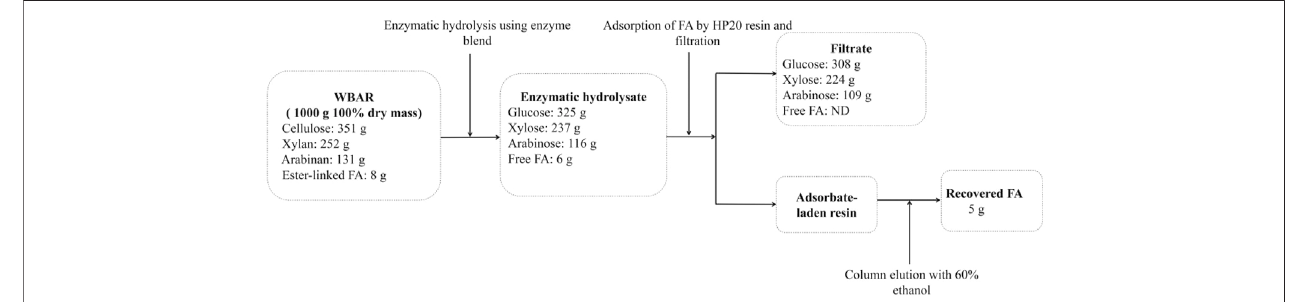
FIGURE 4 | Mass balance of the monosaccharides and ferulic acid from wheat bran autohydrolysis residue. FA, ferulic acid; ND, not detected.